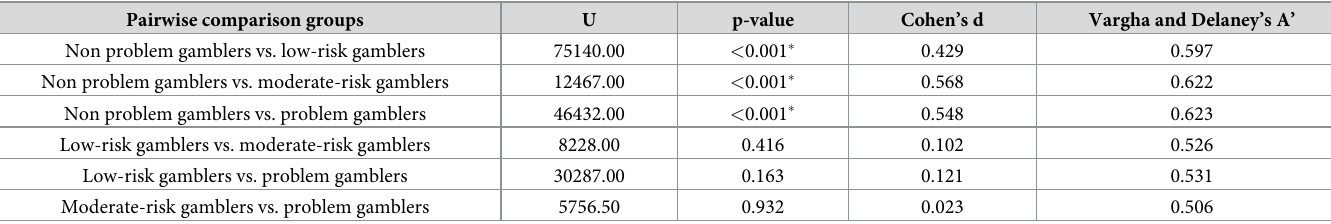
Table 2. Pairwise comparisons of the effects of problem gambling on loot box spending. Pairwise comparison groups